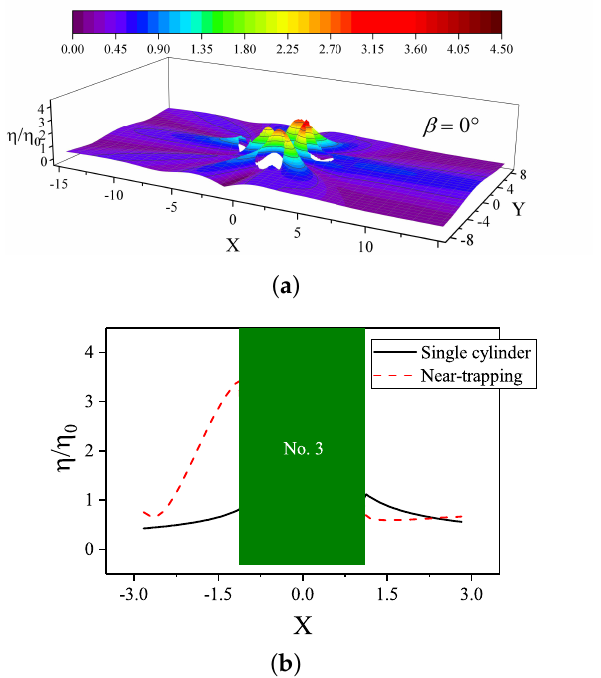
Figure 5. The dimensionless scattered-wave elevation at k 0 a = 1.68: ( a ) perspective view; ( b ) profile of the No. 3 cylinder.